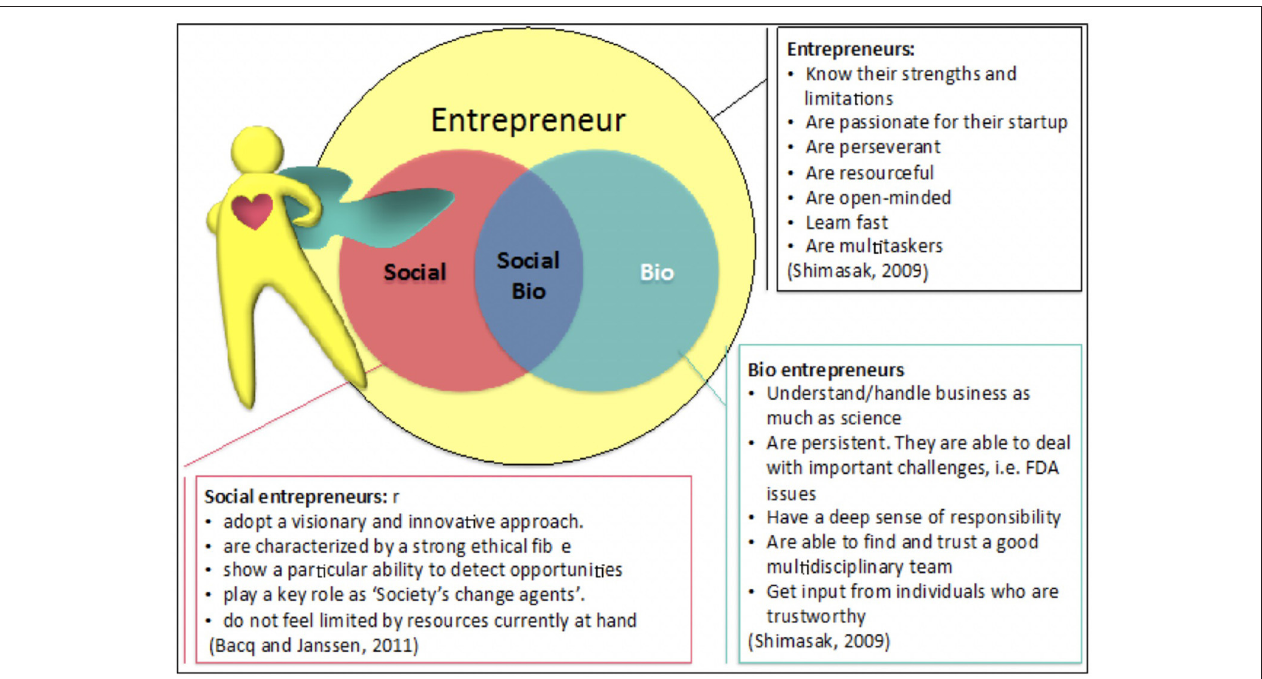
FIGURE 1 | The social bioentrepreneur profile results from the merging of three sets of characteristics corresponding to an entrepreneur, a bio entrepreneur and a social entrepreneur. The social bioentrepreneur needs a solid entrepreneur base, strong skills of a bioentrepreneur, and be driven by the social- entrepreneur motivation. Here the social bioentrepreneur is personified as a single individual, but the skills or characteristics may be covered by a several people in the same